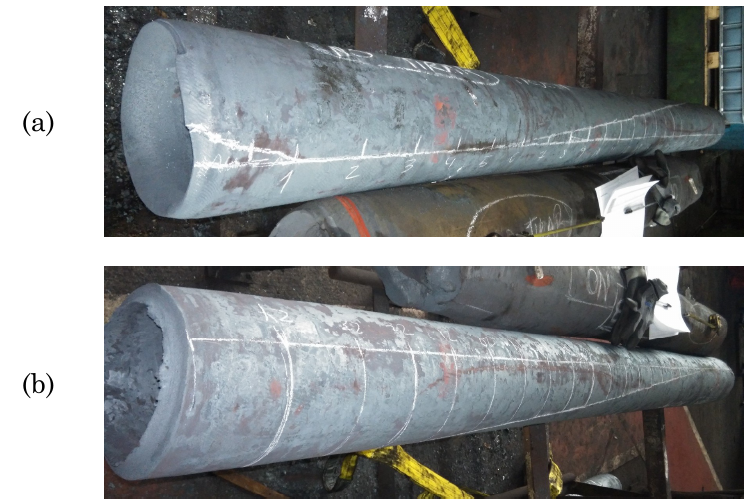
Figure 2. Longitudinal tube torsion: ( a ) view of the head of the tube and ( b ) view of the tail of the